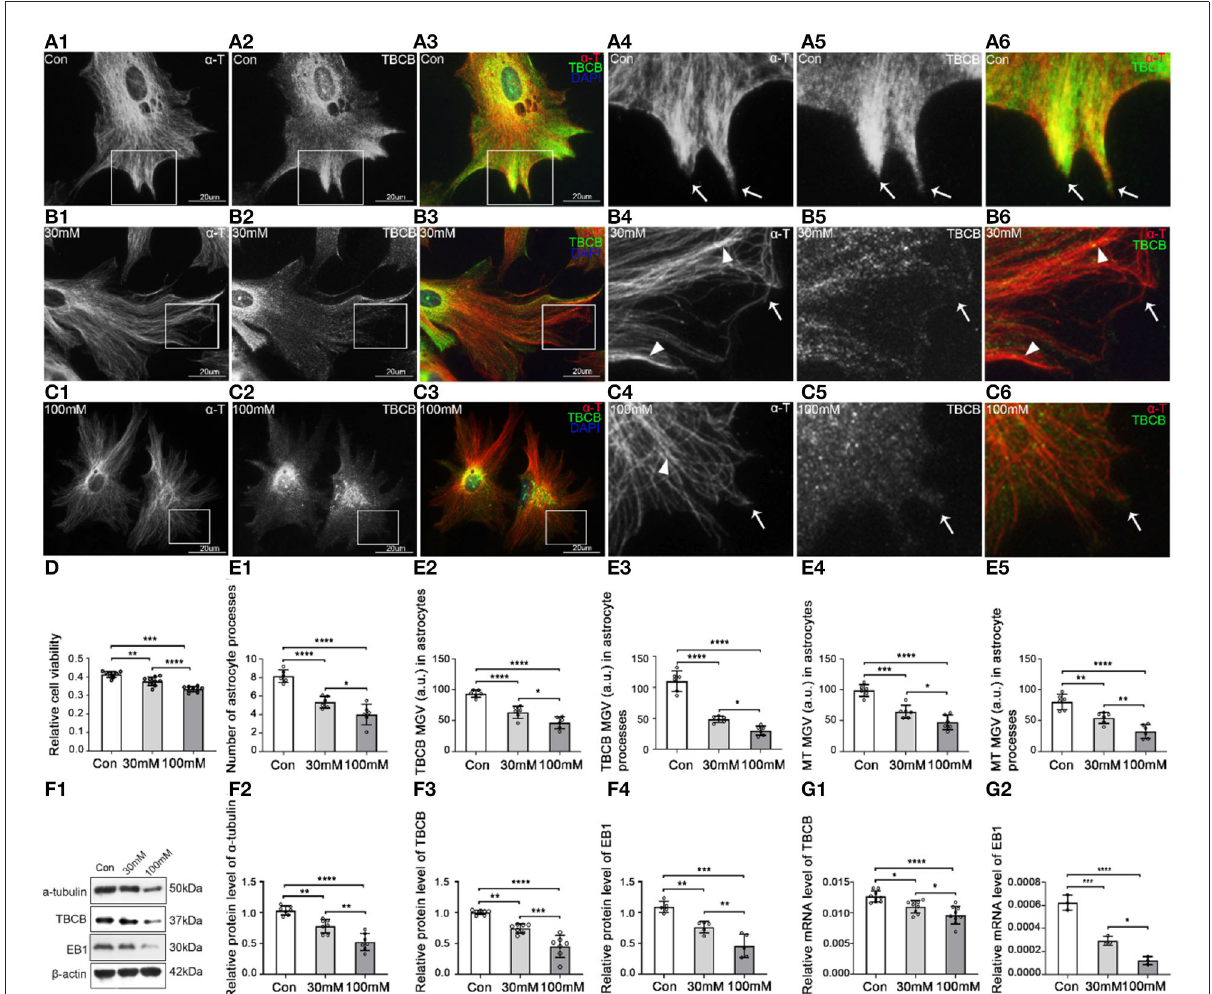
FIGURE1 Morphological changes in astrocytes and expression levels of α -tubulin and TBCB after chronic alcohol exposure. (A–C) Immunofluorescence showed that α -tubulin (red signal) was co-expressed with TBCB (green signal) in astrocytes both in the control group [Con (A) ] and the chronic alcohol exposure group [30mM (B) ; 100mM (C) ]. (D) Relative cell viability was detected by Cell Counting Kit-8 after chronic alcohol exposure. (E) The number of astrocyte processes and mean gray value (MGV) of TBCB and MT in astrocytes and its processes (MGV = Integrated Density/Area) after chronic alcohol exposure group. (F) Western blot and (G) RT-PCR analysis of the levels of the α -tubulin protein and TBCB/EB1 protein and its mRNA after chronic alcohol exposure compared with the control group ( n = 6, p < 0.05). (A–G) Number of panels. * p < 0.05, ** p < 0.01, *** p < 0.001, **** p <